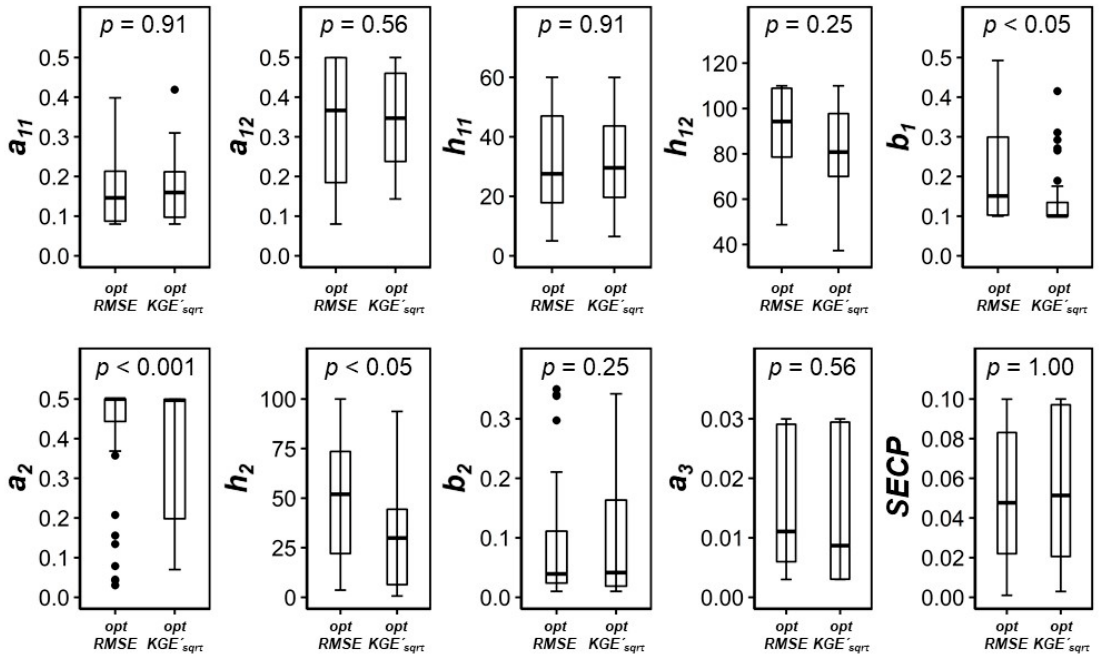
Figure 4. Comparison of the distributions of model parameter values calibrated using the objective functions of optRMSE and optKGE (cid:48) sqrt .